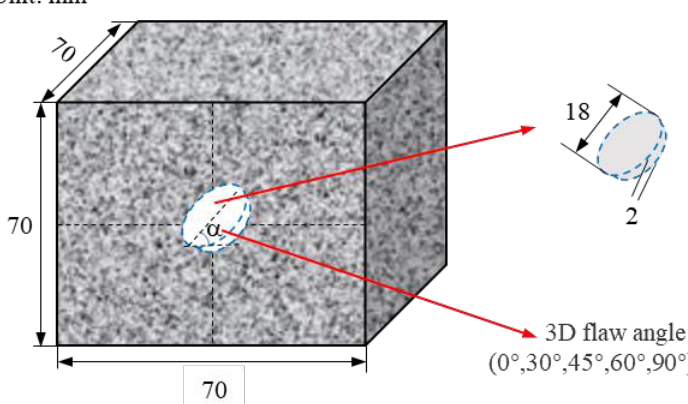
Figure 2. Sample size and flaw geometric parameters.